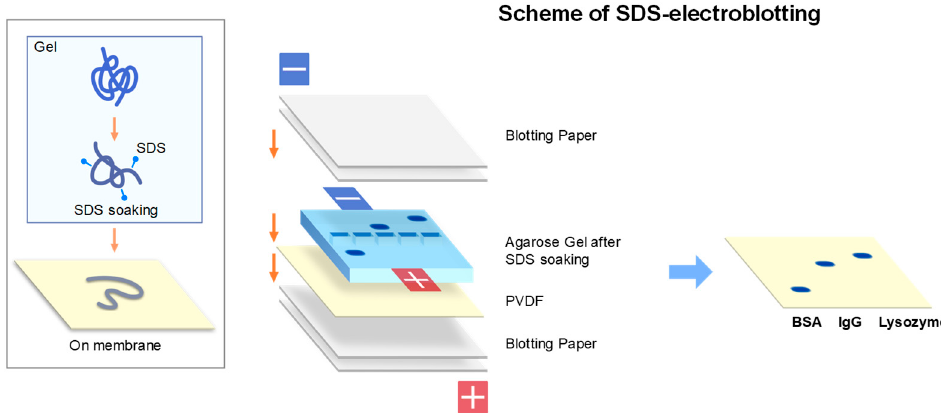
Figure 9. Schematic illustration of SDS-electroblotting. In inset is shown the structure of native protein that unfolds upon exposure to SDS below CMC. Right panel shows actual setup of SDS-soaked agarose gel in SDS-electroblotting. Blotting (Semi-dry) was typically performed at a constant current of 1.5 mA/cm 2 for 30 min.